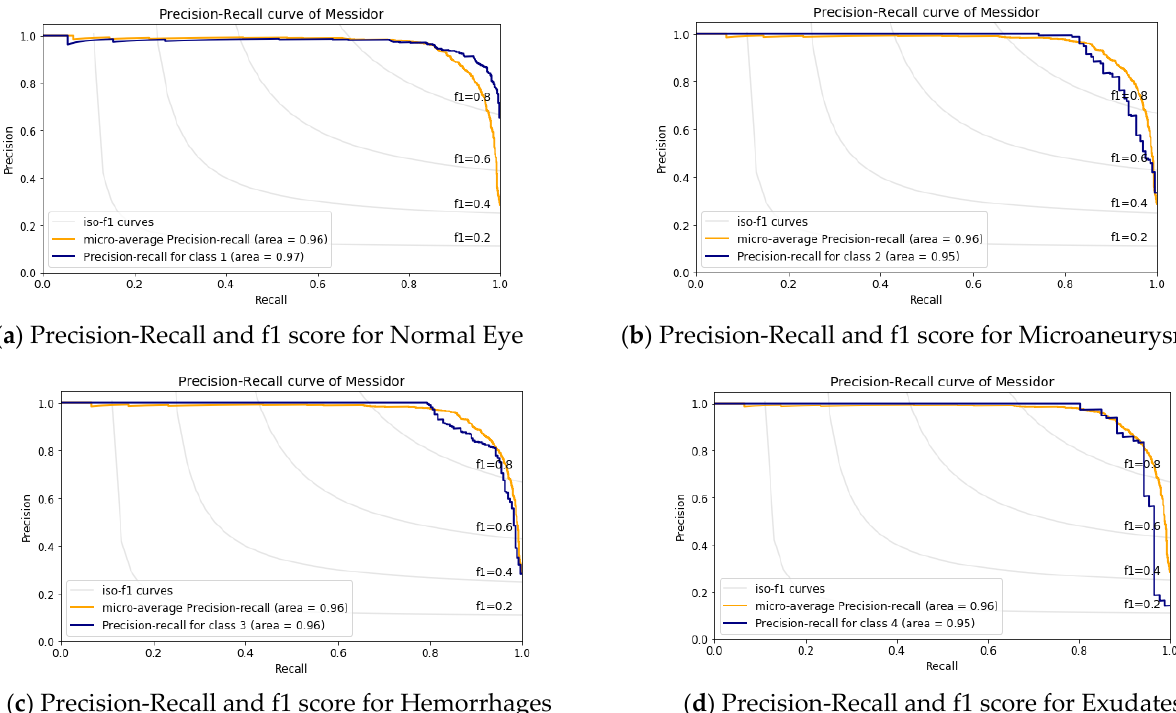
Figure 9. Precision-Recall and f1 score analysis for the MESSIDOR dataset.